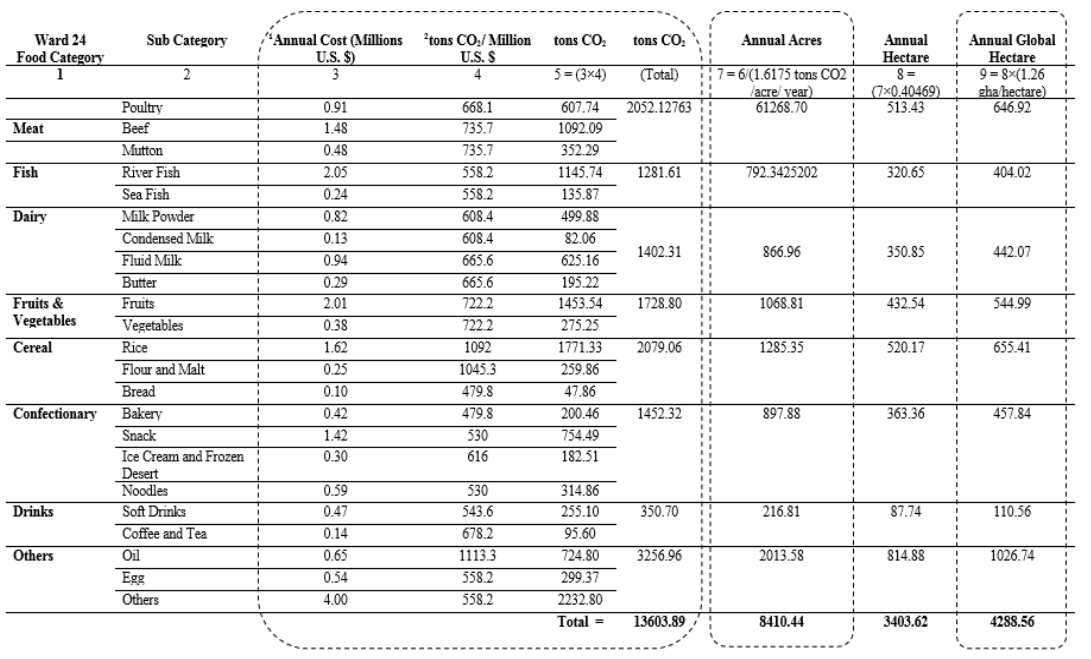
Figure 11. Food consumption footprint calculation and derivation. Source: 1 Household survey of Ward 24 RA (2015), [68]; 2 [66]).